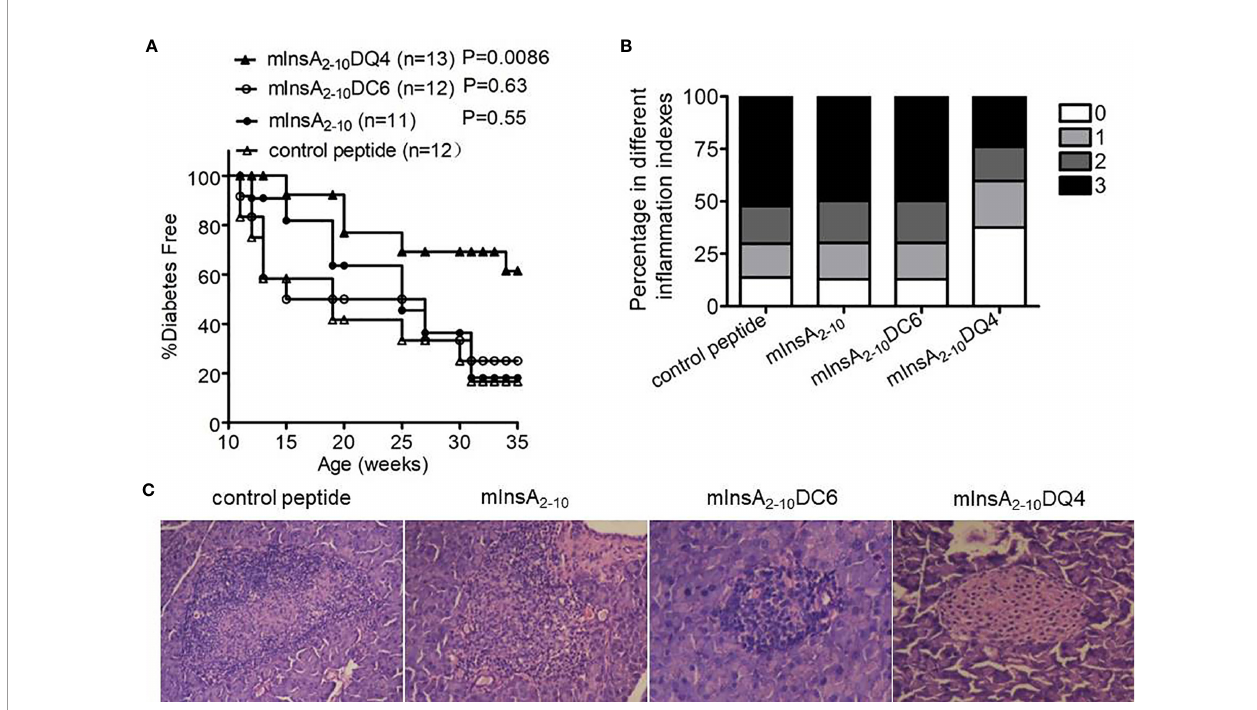
FIGURE 4 | The treatment with mInsA 2-10 DQ4 prevented diabetes development in NOD. b 2 m null .HHD mice. NOD. b 2 m null .HHD female mice were injected intraperitoneally (once weekly) at 4 – 9 weeks of age with 100 m g of peptide mInsA 2-10 , mInsA 2-10 DQ4, mInsA 2-10 DC6, or OVA 257-264 . (A) Mice were monitored for diabetes development. (B) Histopathological evaluation of pancreatic sections from indicated peptide-treated NOD. b 2 m null .HHD mice at 12 weeks of age. (C) Representative hematoxylin and eosin – stained paraf fi n-embedded pancreas sections (200 × magni fi cation) are